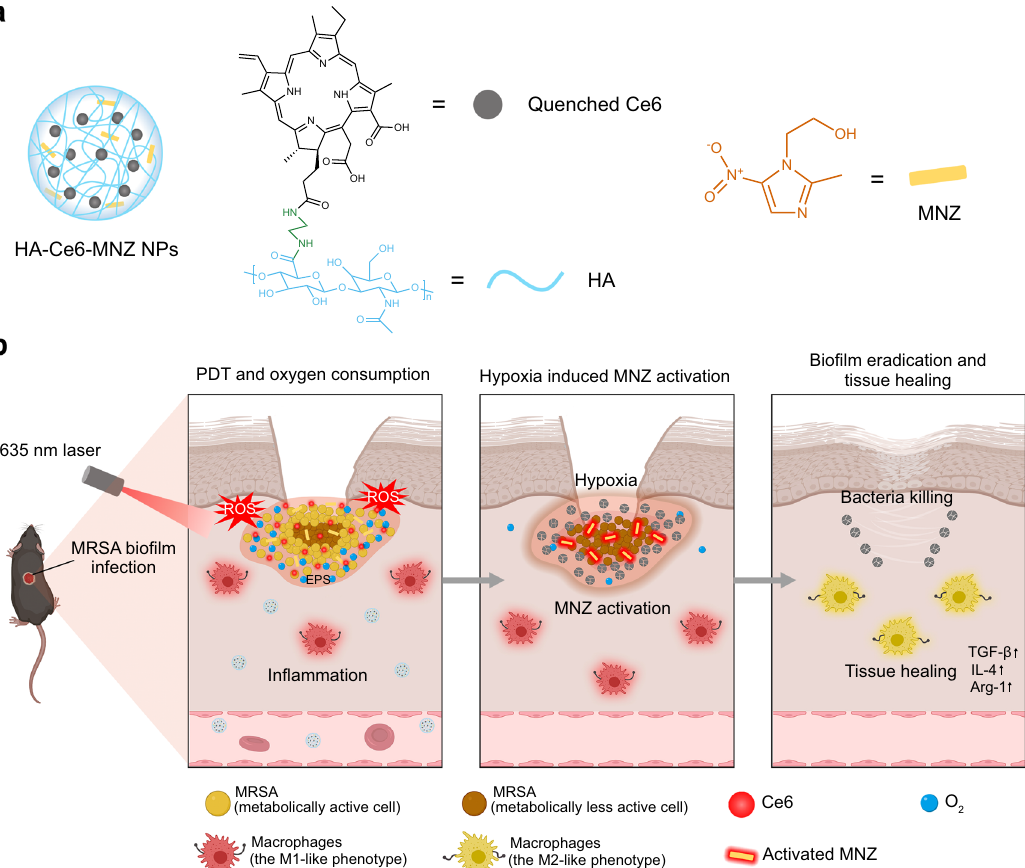
Fig. 1 Potentiating hypoxia by PDT for antibiotic activation to combat MRSA bio fi lm infections. a Schematic illustration of the structure of HA-Ce6- MNZ nanoparticles (HCM NPs, hyaluronic acid (HA), chlorin e6 (Ce6), metronidazole (MNZ)). b The therapeutic processes of MRSA bio fi lms, including the release of Ce6 and MNZ, PDT-potentiated hypoxia, activation of MNZ, elimination of bacterial bio fi lms, and infected tissue